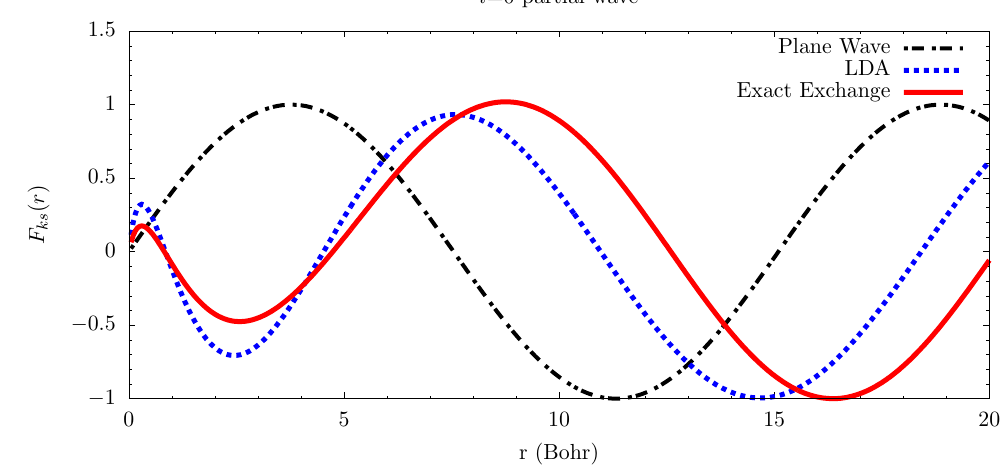
Figure 4. Same as Figure 3, but reacting to the Li 1 s 2 2 s